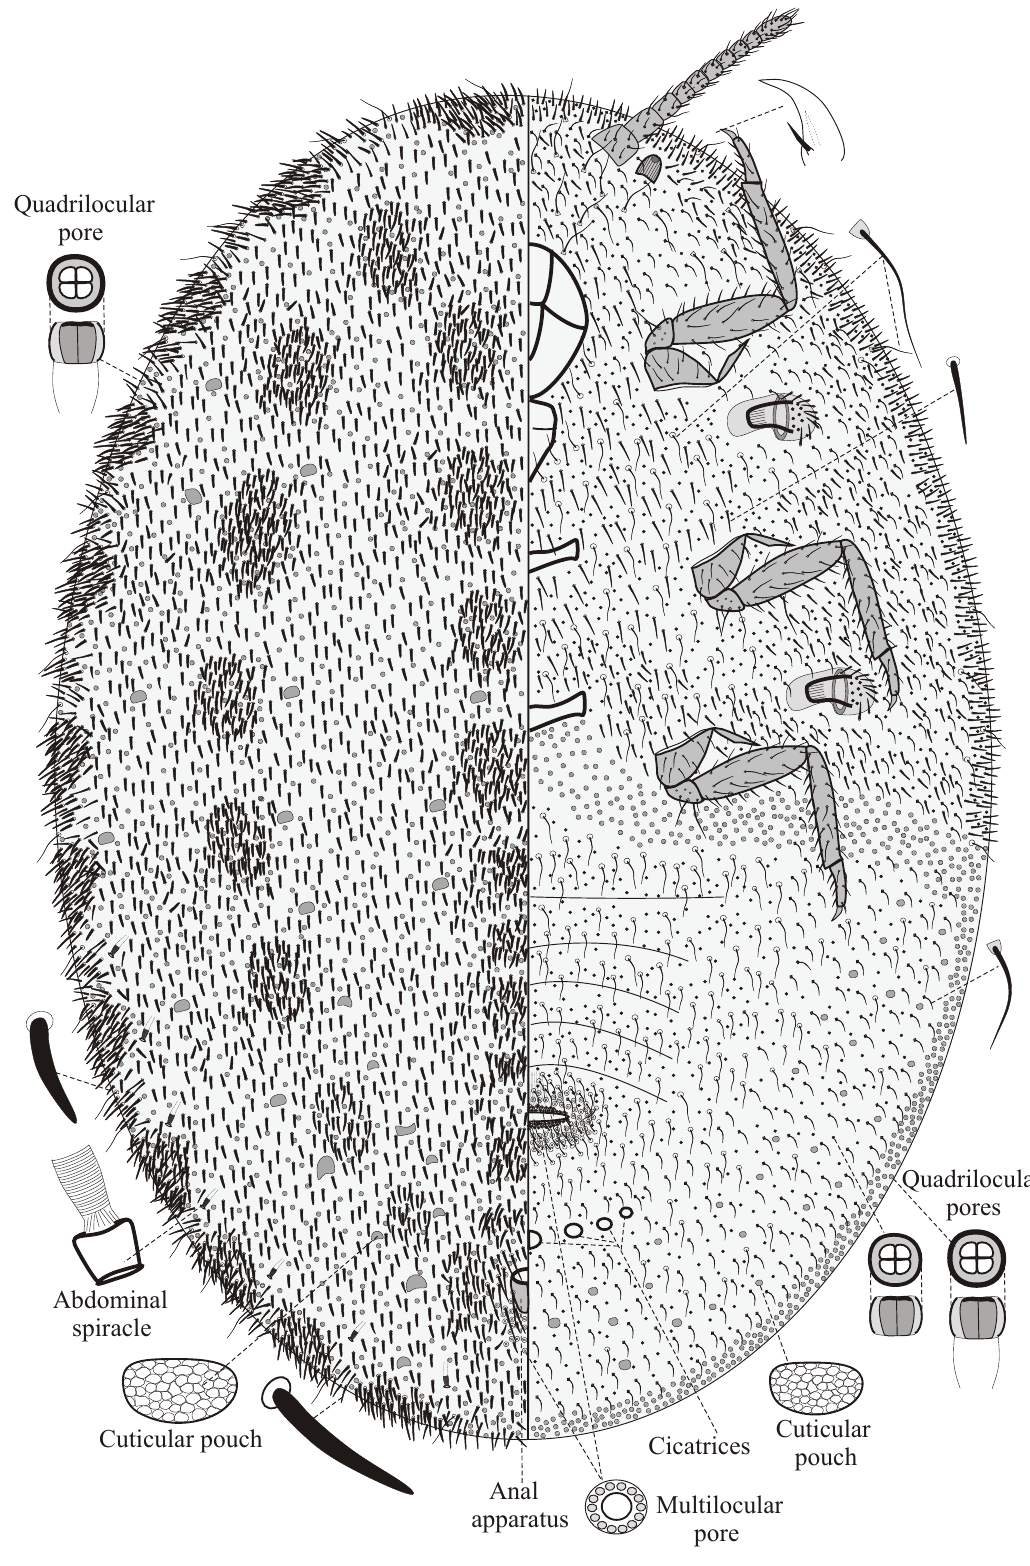
Fig. 3. Hemaspidoproctus cinereus (Green, 1922), comb. nov. Morphology of the adult ♀ from India (Allahabad) (ZIN RAS, K 1502). Not to